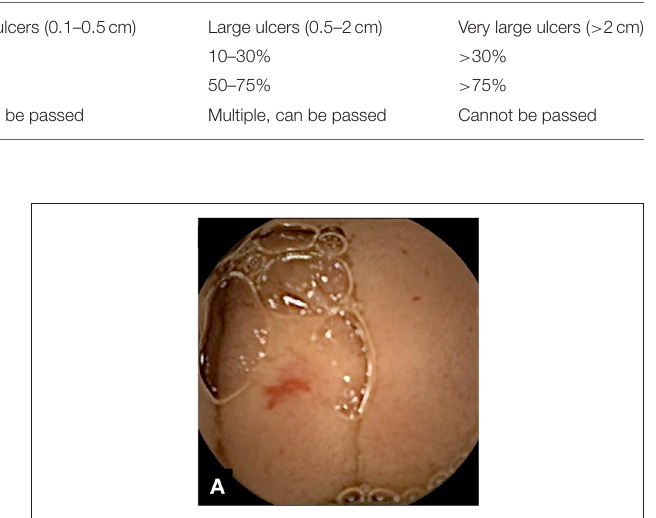
FIGURE 8 | Arteriovenous malformation.